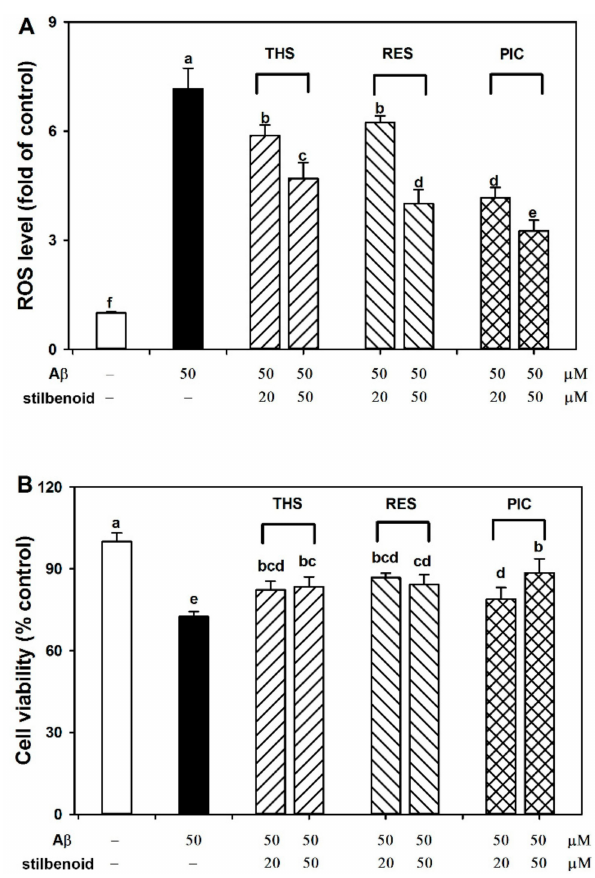
Figure 3. Effects of trans -4-hydroxystilbene (THS), resveratrol (RES), and piceatannol (PIC) on ( A ) intracellular ROS and ( B ) cell viability in A β 25-35 -induced rat primary cerebral cortex neurons. Each bar represents the mean ± SD of three independent experiments. Different letters in each figure indicate significant differences by Duncan’s multiple range test at p <